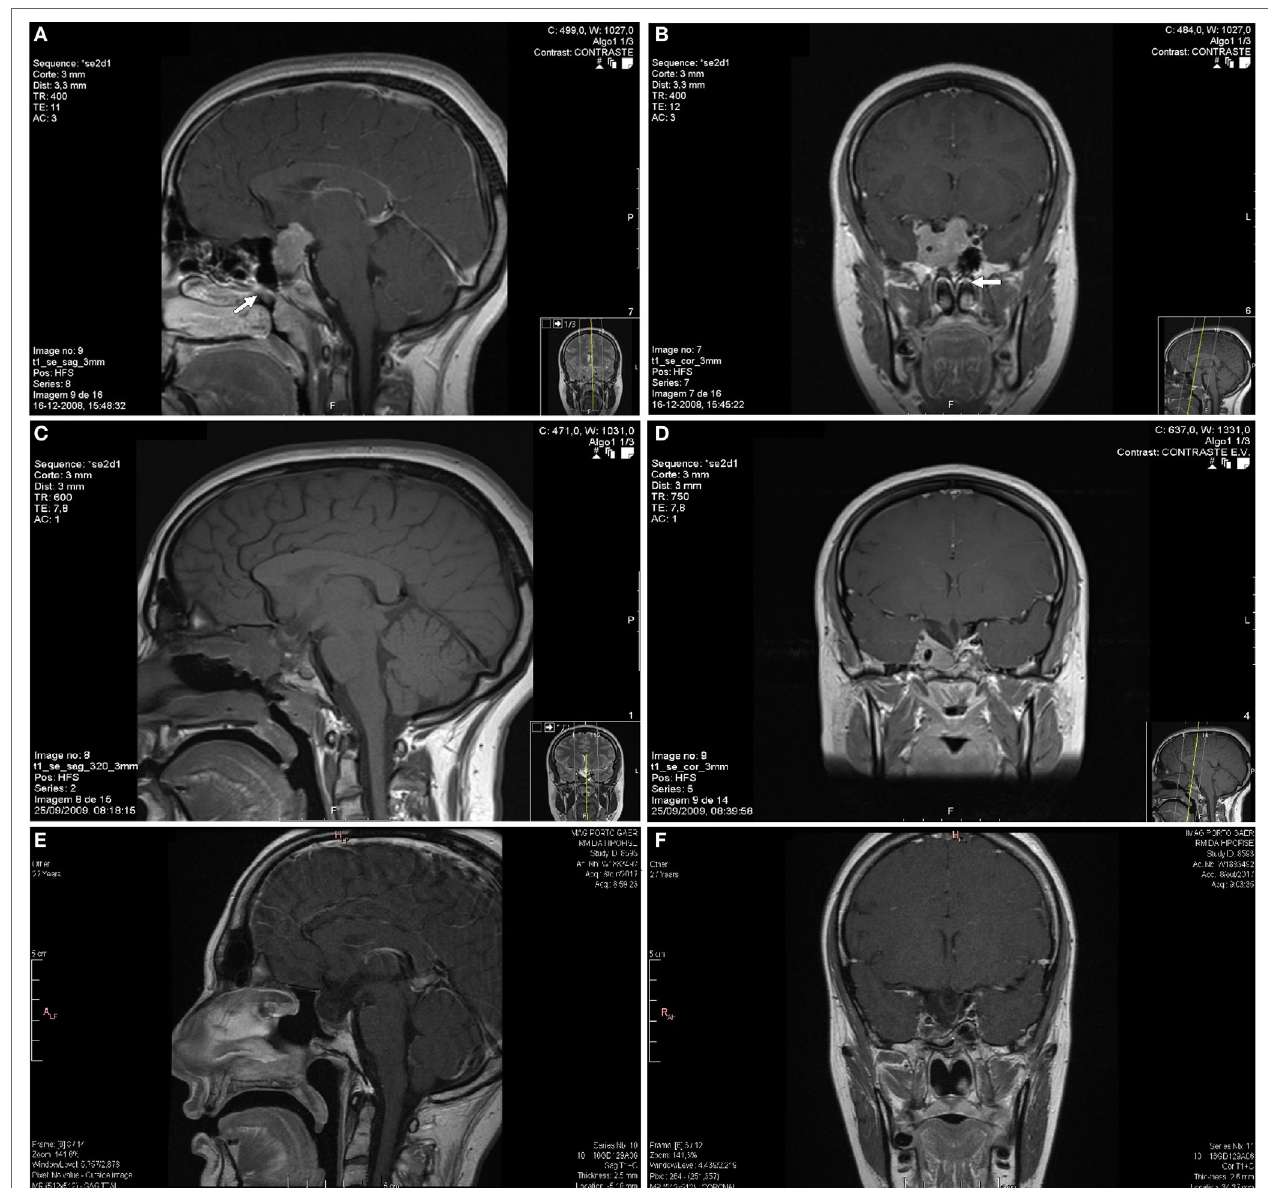
FIGURe 1 | Sagittal (a) and coronal (B) plane of the first pituitary magnetic resonance imaging (MRI) with an invasive macroadenoma with gadolinium enhancement. The pituitary tumor measured 32 mm × 30 mm × 25.5 mm in anteroposterior, craniocaudal, and transverse dimensions, respectively. The lesion had invasion of the right cavernous sinus, superior deviation of the left internal carotid artery, sphenoid sinus invasion, and compression and stretching of the optical chiasm. The tumor was isossignal area in T1 and T2 with small cysts and had marked contrast enhancement. The possible nasal metastasis was localized near the sphenoid rostrum in the left nasal fossa (arrows). The postoperative MRI (C,D) revealed a persistent expansive pituitary lesion with right cavernous sinus invasion. The last pituitary MRI (e,F) performed in October 2017 showed a pituitary tumor with markedly reduced